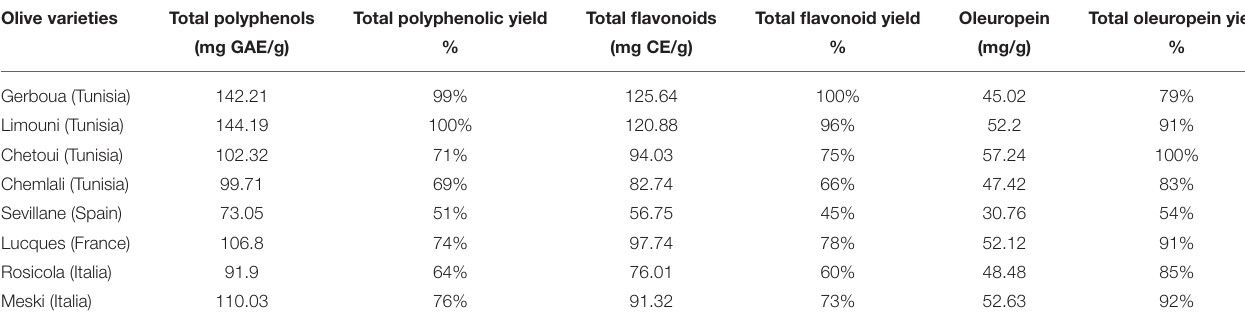
TABLE 3 | Total polyphenols, flavonoids and oleuropein of olive leaf extracts (Ben Salah and Abdelmelek, 2012). Olive varieties